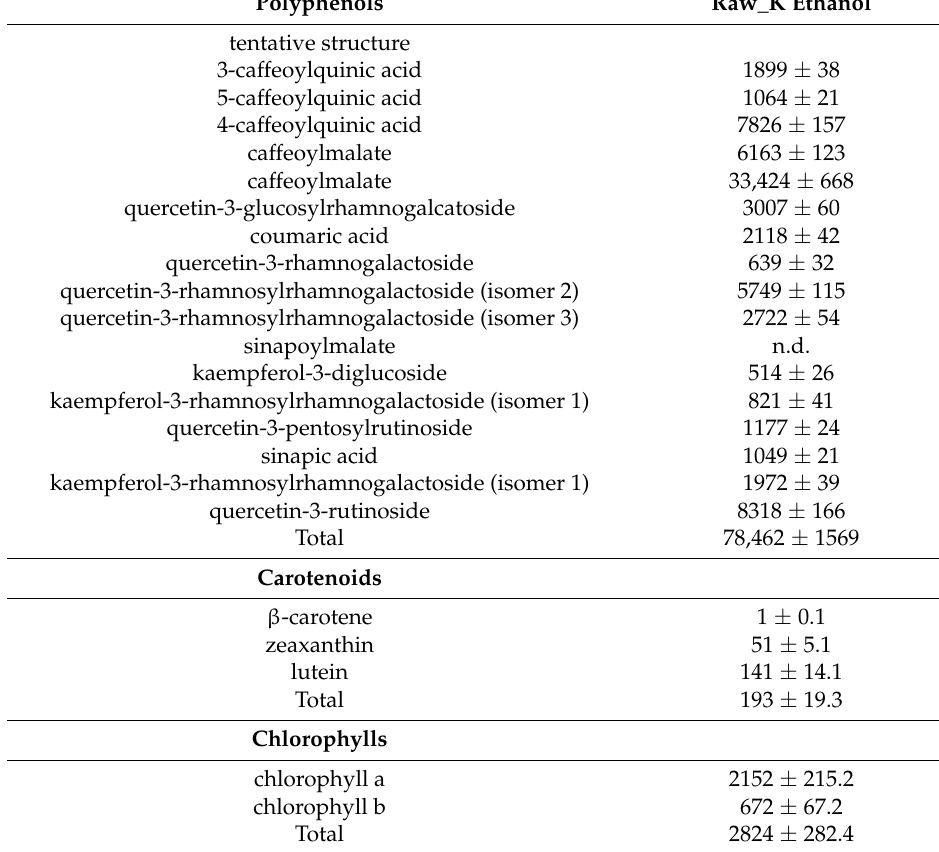
Table 5. Phytochemical content in the extracts of S. scabrum in µ g/g DM (location D). The data are presented as phytochemical content ± average analytical